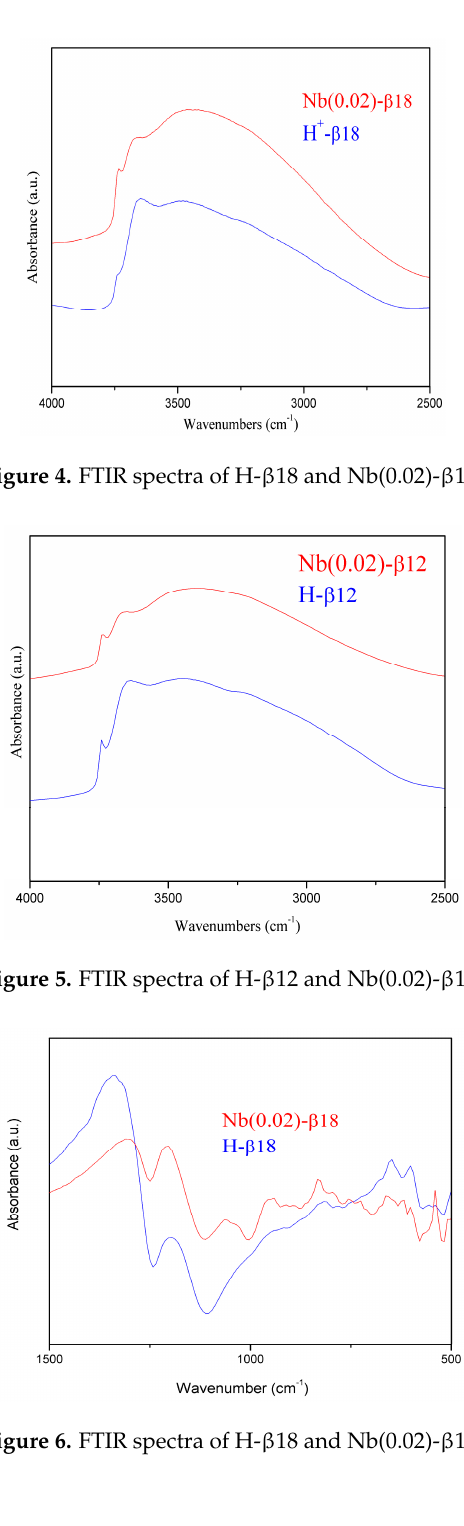
Figure 6. FTIR spectra of H- β 18 and Nb(0.02)- β 18.